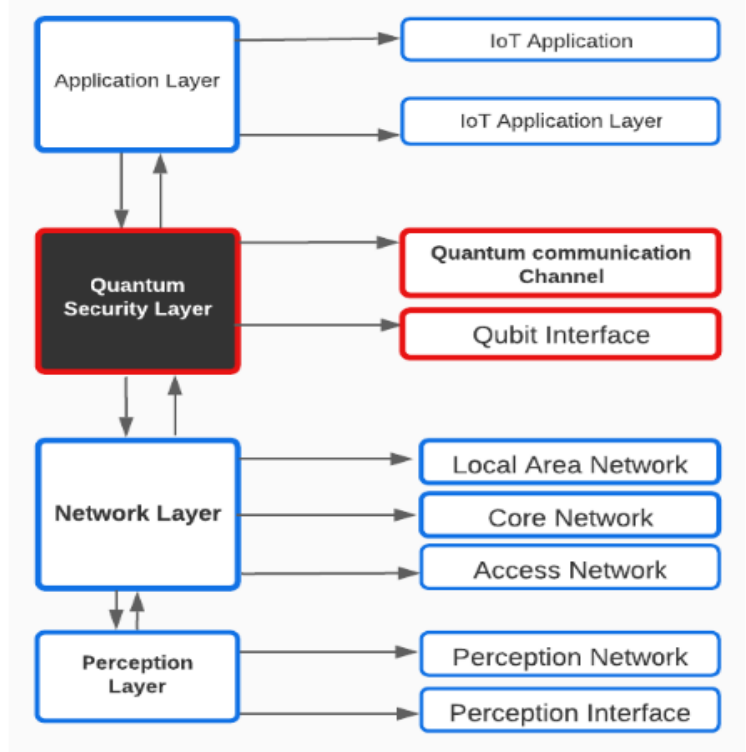
Figure 2. Proposed network architecture abstract diagram.